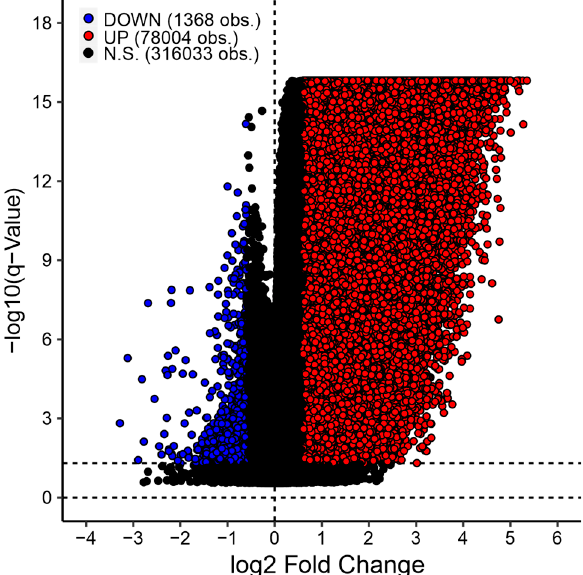
Figure 4. Volcano plot of differentially methylated probes (DMPs) between EBVaGC and EBVnGC samples for the TCGA STAD dataset. Red points represent probes that are significantly up-methylated in EBVaGCs when compared to EBVnGCs. Blue points represent probes that are significantly down-methylated in EBVaGCs when compared to EBVnGCs. Black-colored points represent probes that are not significantly up- or down-methylated or show less than a 1.5-fold decrease or increase in probe methylation in EBVaGC compared to EBVnGC. Calculations were performed with an FDR of 5%.